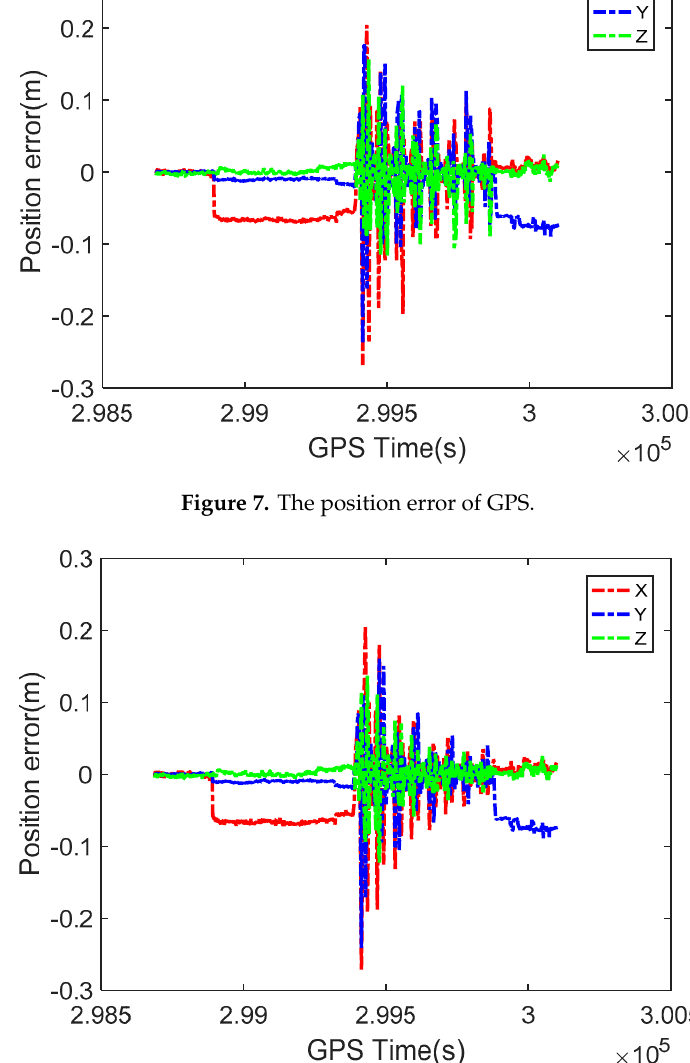
Figure 8. The position error of the tightly coupled system.